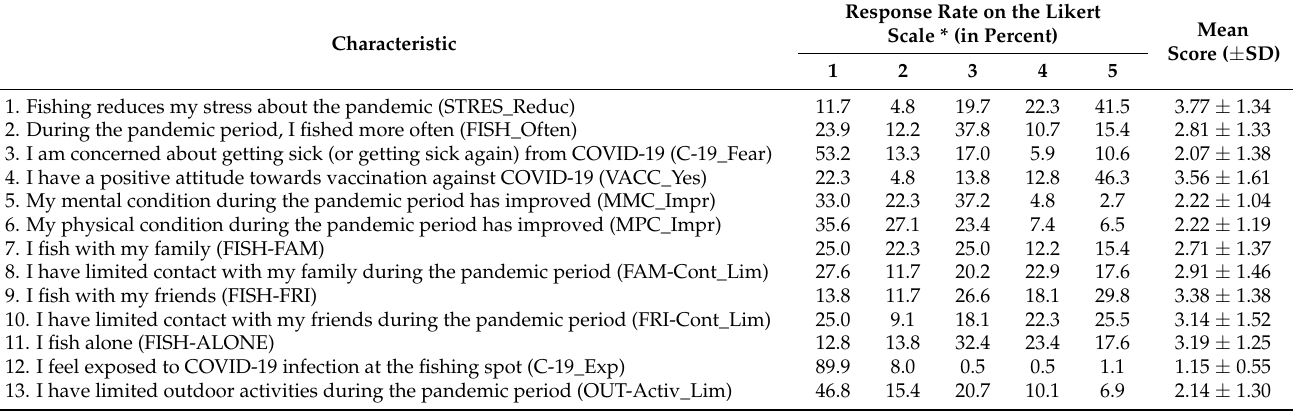
Table 1. Perceptions and behavior toward angling and life attitudes during the pandemic period.